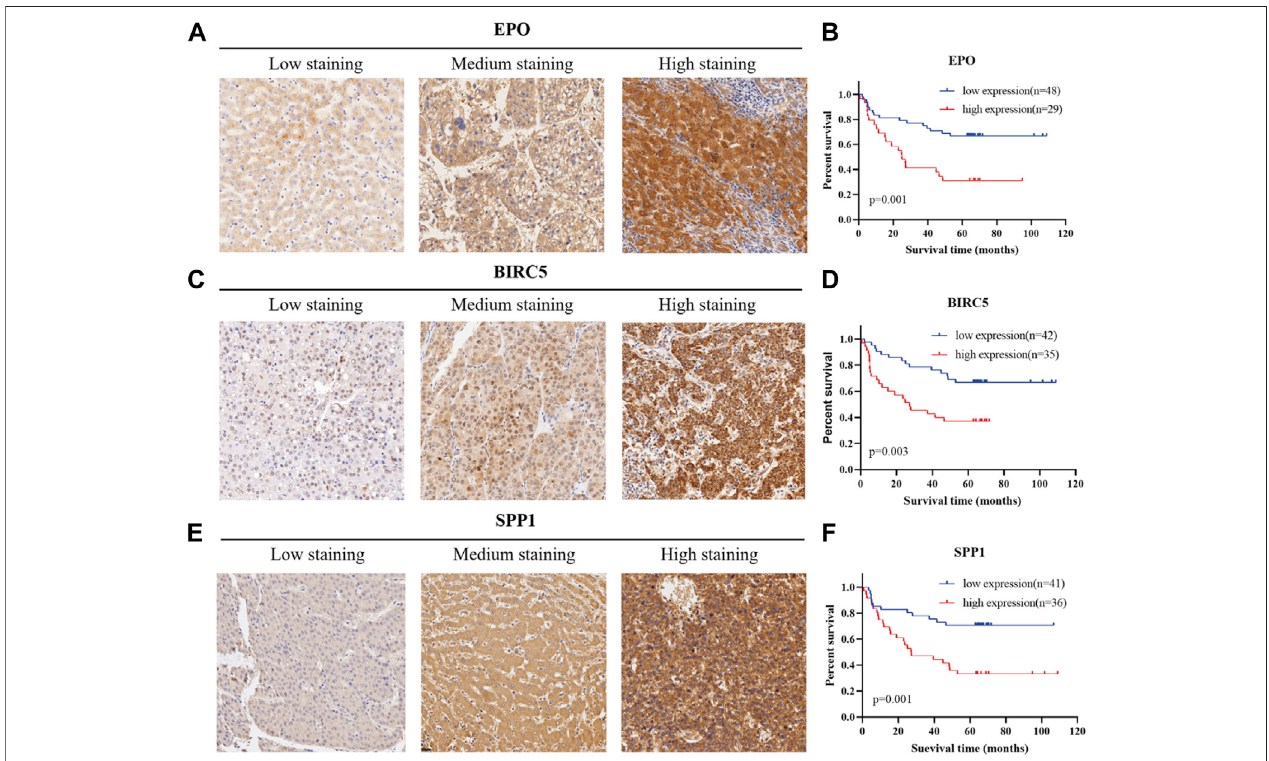
FIGURE 8 | Veri fi cation of the prognostic ef fi ciency of the three markers in HCC using a tissue microarray. (A) , (C) , (E) Representative immunohistochemistry imagesinHCCtissuesofEPO,BIRC5,andSPP1(200X). (B) , (D) , (F) Kaplan – Meiercurvesforoverallsurvivalof77HCCpatientswithdifferentproteinexpressionlevelsof EPO, BIRC5, and